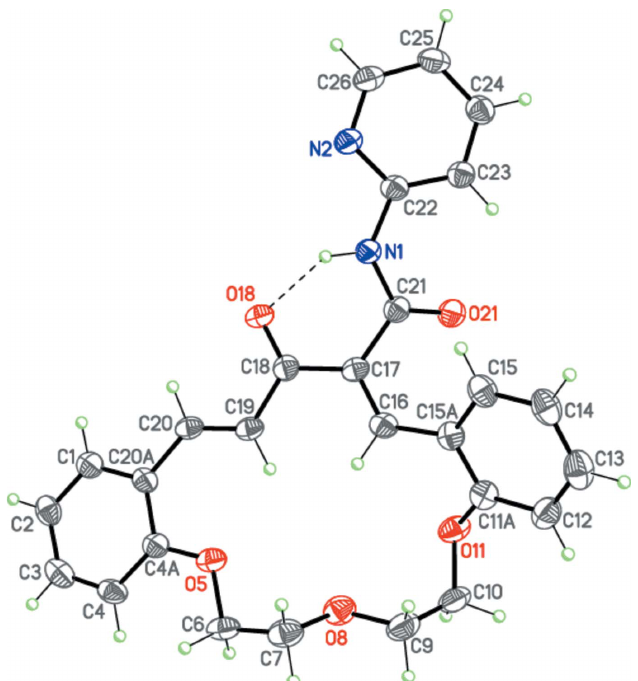
Figure 1 Molecular structure of ( 3 ) with displacement ellipsoids shown at the 50% probability level. H atoms are presented as small spheres of arbitrary radius. Dashed line indicates the intramolecular N—H (cid:2)(cid:2)(cid:2) O hydrogen